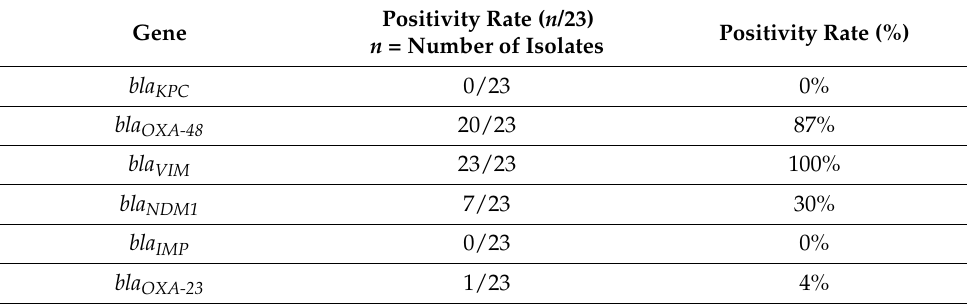
Table 4. Distribution of carbapenem genes in 23 isolates. Positivity Rate ( n /23) Gene n = Number of